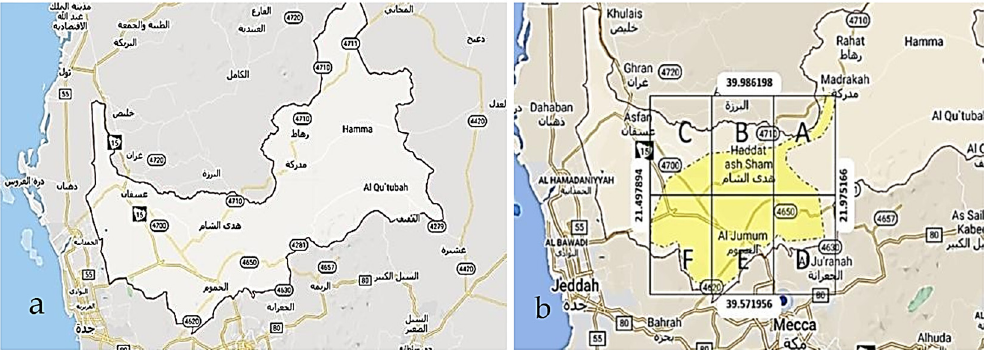
Figure 1. ( a ) Geographical boundaries of Aljumum Governorate. ( b ) Map showing the study areas divided into six zones (A, B, C, D, E, and F) and their coordinates. Google (2021), [google map for Aljumum region], https://goo.gl/maps/AKDQb3CfKQHwBoL59.